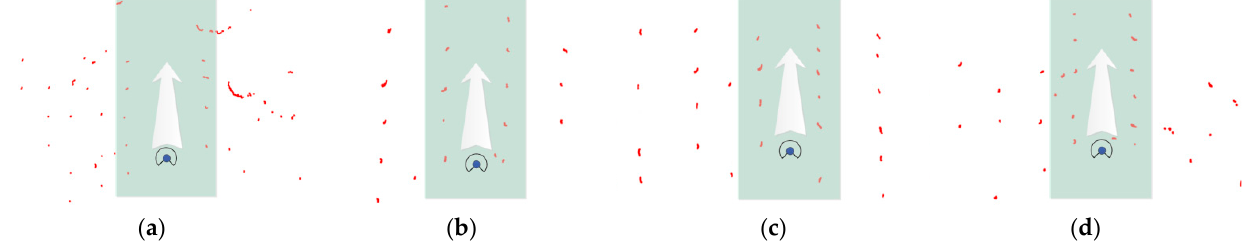
Figure 4. 2D lidar point cloud autonomous navigation system orientation in different forest scene. ( a ) Point cloud 1; ( b ) Point cloud 2; ( c ) Point cloud 3; ( d ) Point cloud 4.